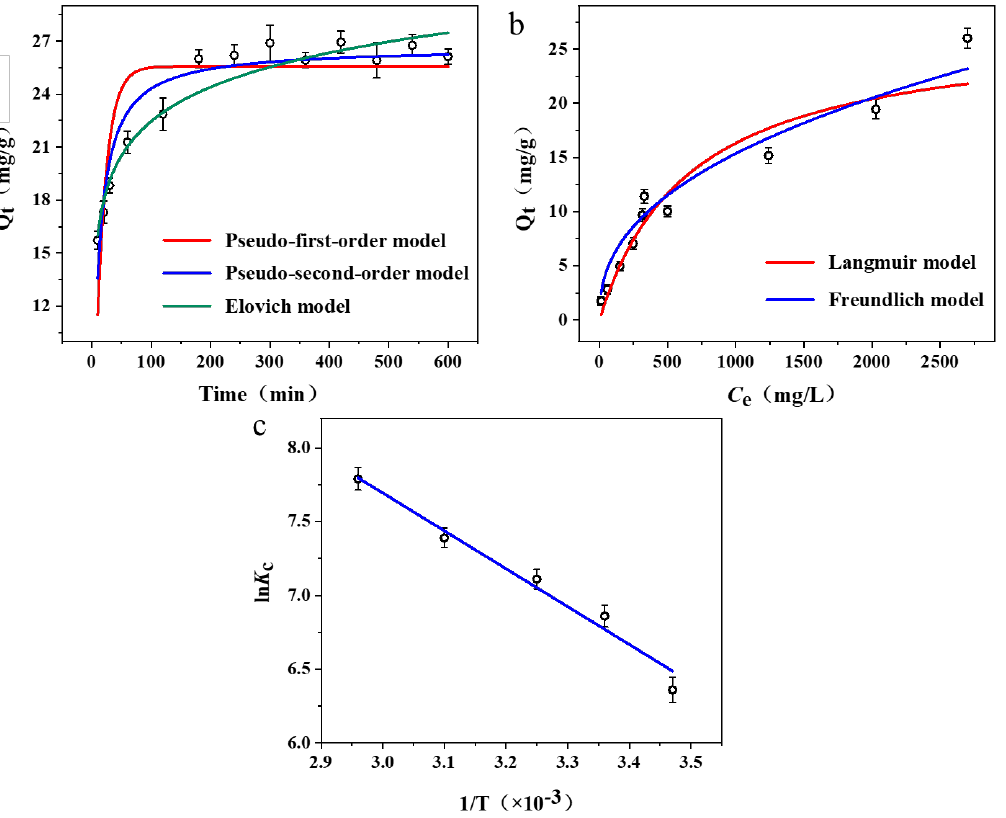
Figure 4. ( a ) Kinetic model fitting; ( b ) Isotherm Fitting; ( c ) Thermodynamic Fitting. Table 4. Different parameters and errors values associated with isotherm models. Langmuir Freundlich